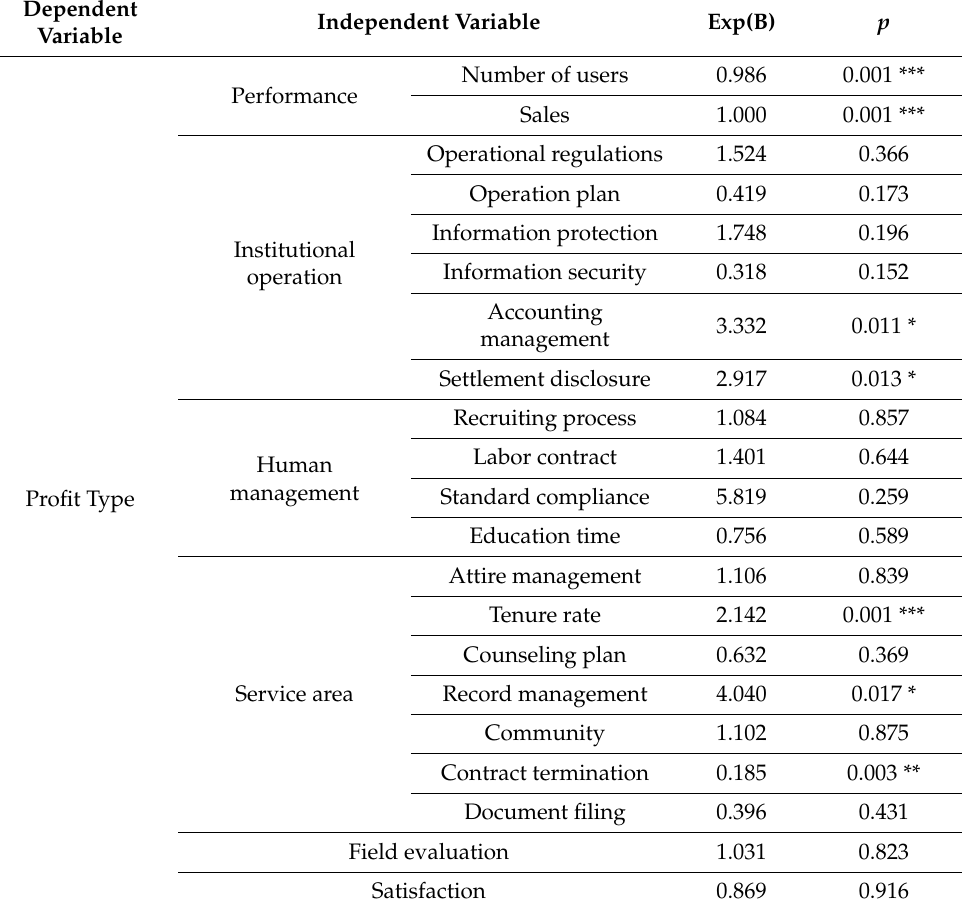
Table 2. Common indexes for QE (Quality Evaluation) of social services in 2013 (for-profit) ( n =